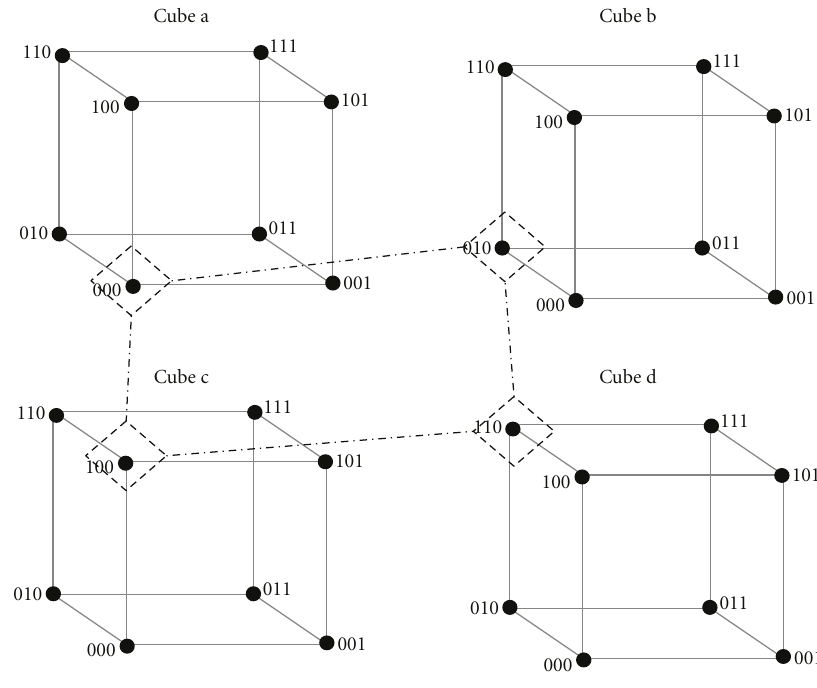
Figure 6: A BCC 4-cube